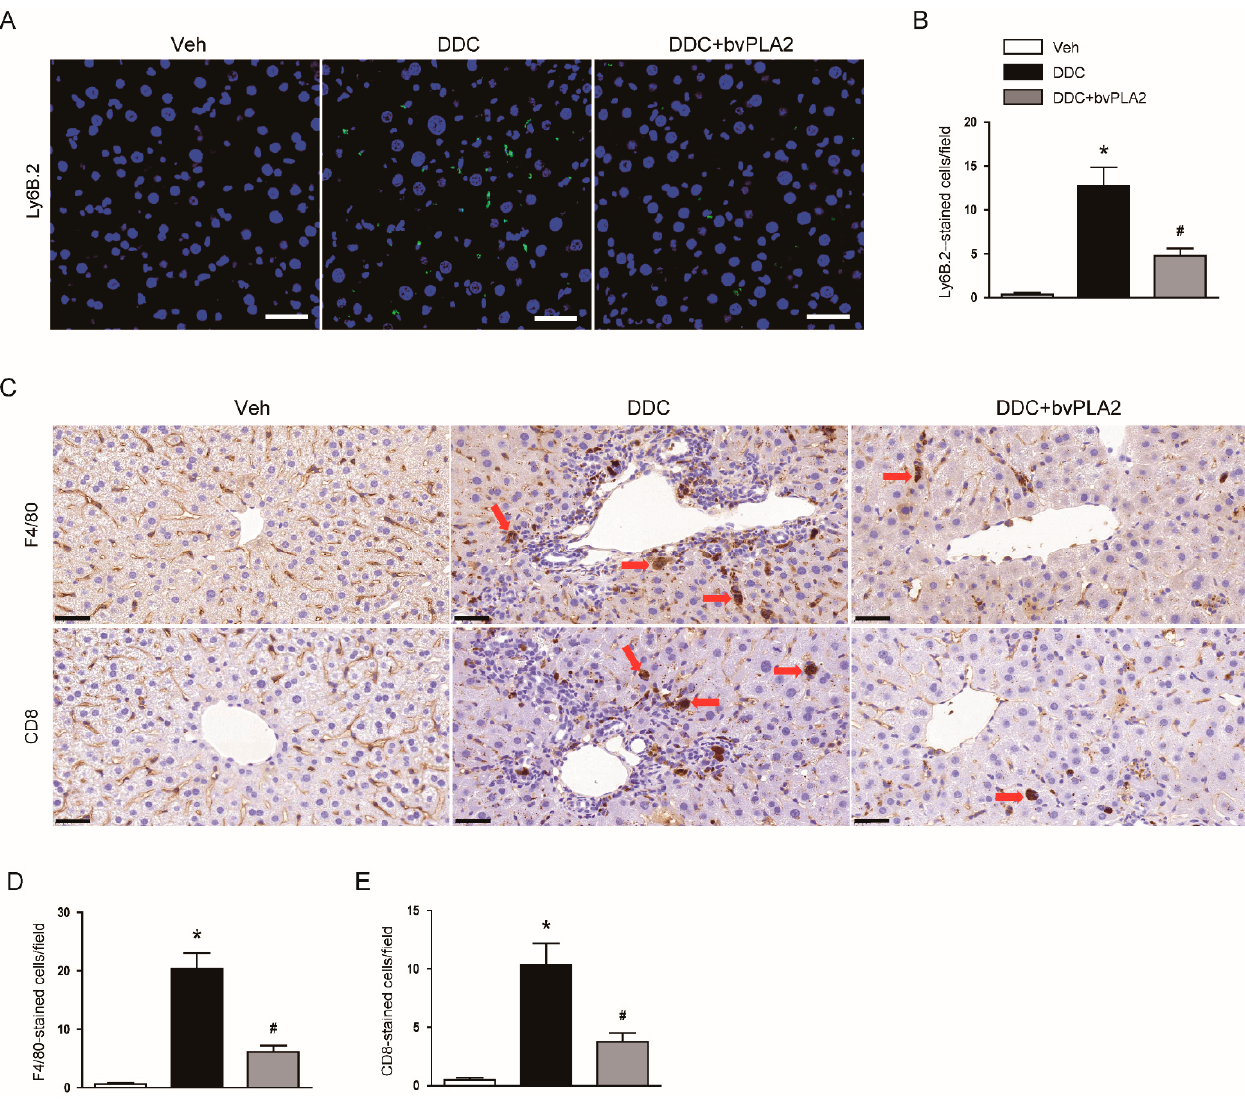
Figure 8. Effect of bvPLA2 on the accumulation of pro-inflammatory cells in DDC diet-fed mice. ( A ) Immunofluorescent staining of liver tissues for Ly6B.2. Scale bar = 40 μ m. ( B ) Number of Ly6B.2-stained cells. ( C ) Immunohistochemical staining of liver tissues for F4/80 or CD8. Red arrows indicate positively stained cells. Scale bar = 100 μ m. ( D ) Number of F4/80-stained cells. ( E ) Number of CD8-stained cells. n = 8 per group. * p < 0.05 vs. Veh. # p < 0.05 vs. DDC.